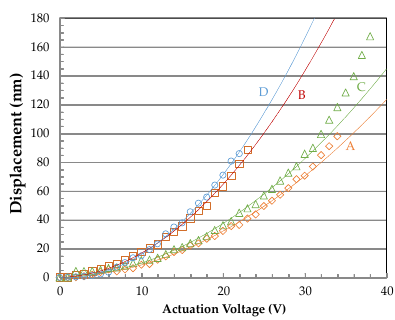
Figure 7. Measured displacement of all of the specimens A–D against applied actuation voltage on the electrostatic actuator. Specimens were fractured at the highest voltage of the plots. Fitting lines indicate quadratic function. Table 2. Summary of the tensile testing results.